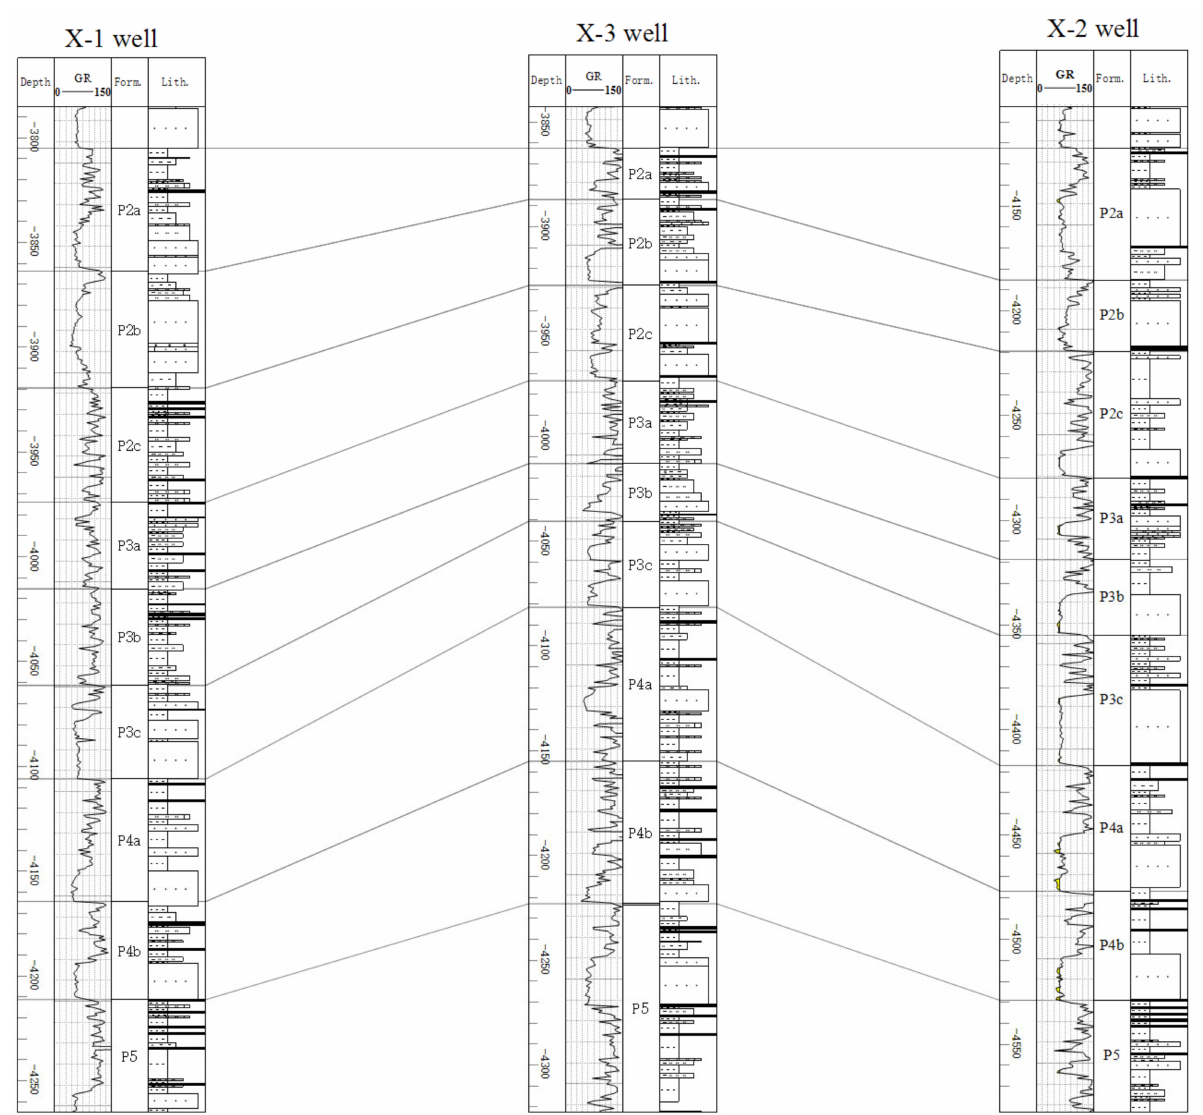
Figure 2. Litho-stratigraphic units of the Pinghu Formation in the Xihu Depression. For locations of the wells, see Figure